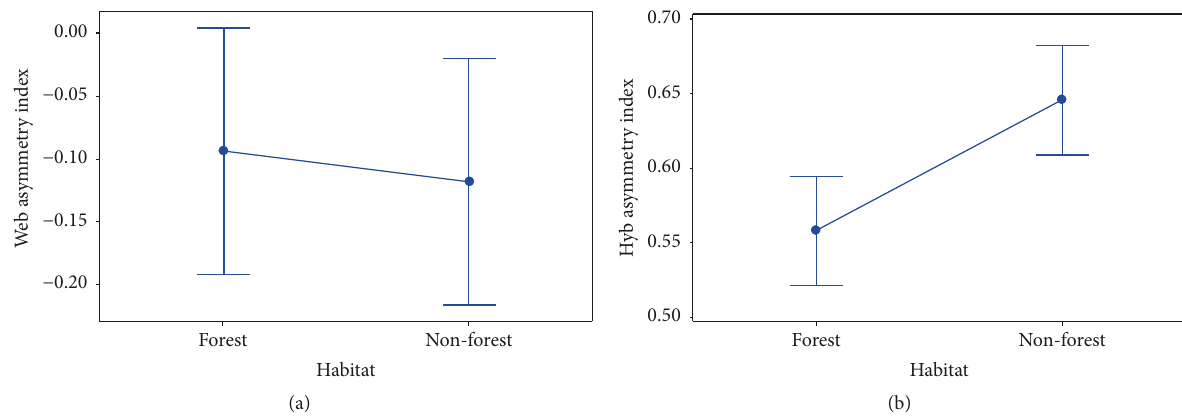
Figure 3: Variations in (a) web and (b) hub indices of symmetry in N. pilpes inhabiting forest and nonforest habitats.